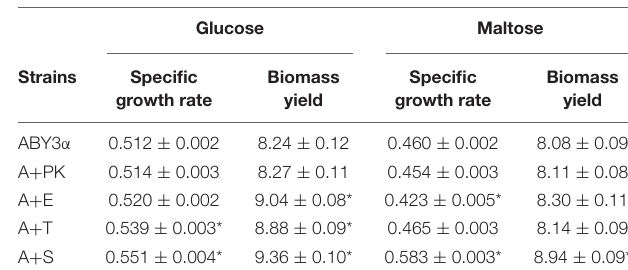
TABLE 3 | Specific growth rate (h − 1 ) and biomass yield (g/L) of the strains carrying genes